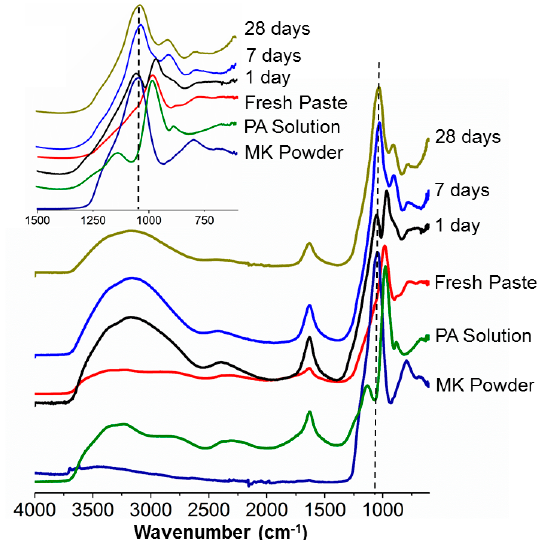
Figure 4. Infrared absorption spectra of commercial MK used as the raw precursor; diluted PA solution used for the synthesis of MKPC; and of MKPC (Al/P = 0.94), cured at room temperature, recorded at various curing ages (as a fresh paste, after 1, 7, and 28 days).